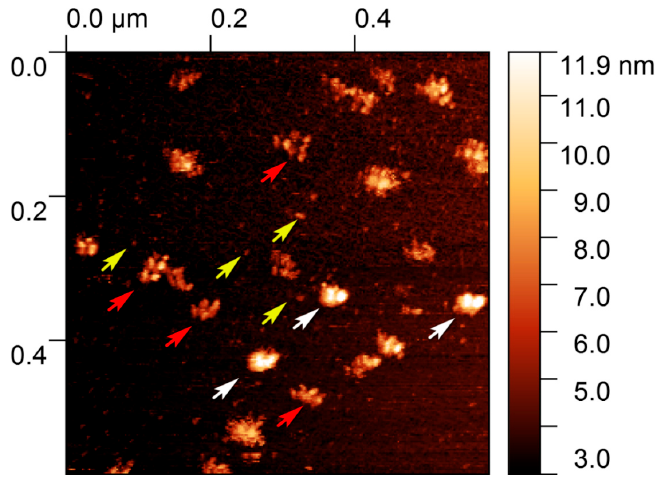
Figure A1. Nanoparticle tracking analysis of particle size and concentration. The initial sample was diluted 10,000 times.